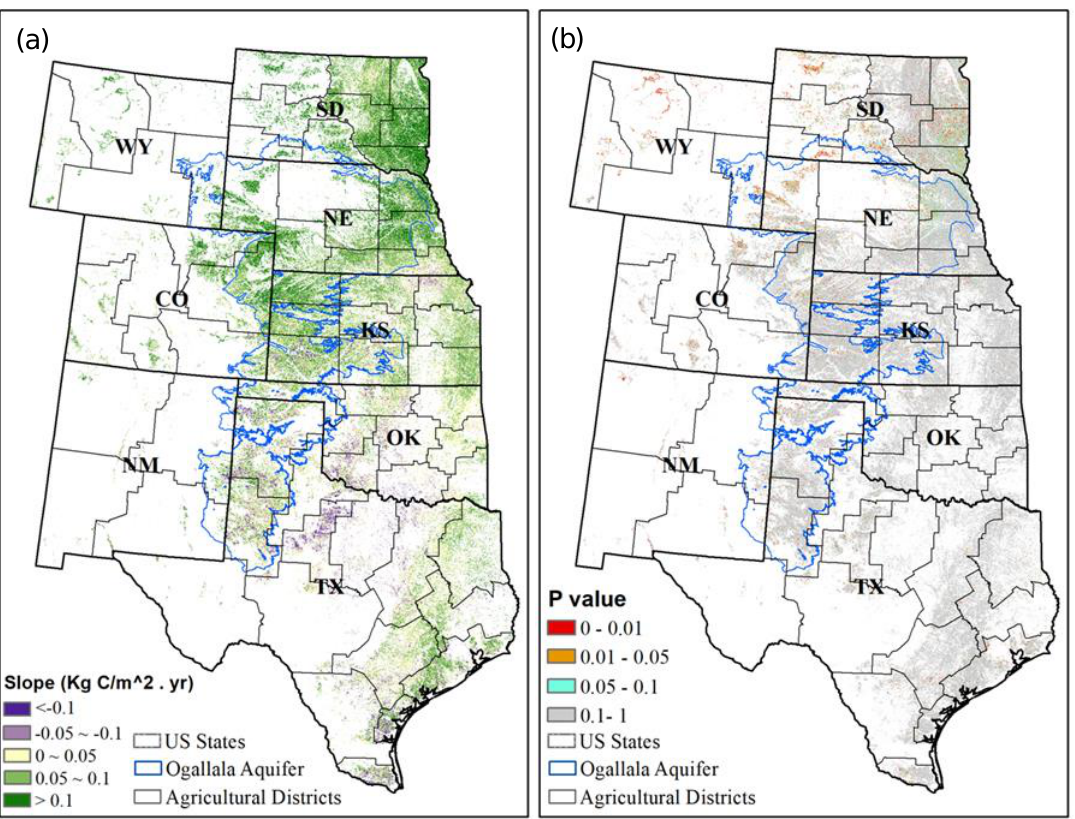
Figure 4. Net primary production (NPP) trend ( a ) and NPP trend significance level for the period 2001 to 2018 ( b ). (Forest and grassland are masked to better relate NPP to agriculture).